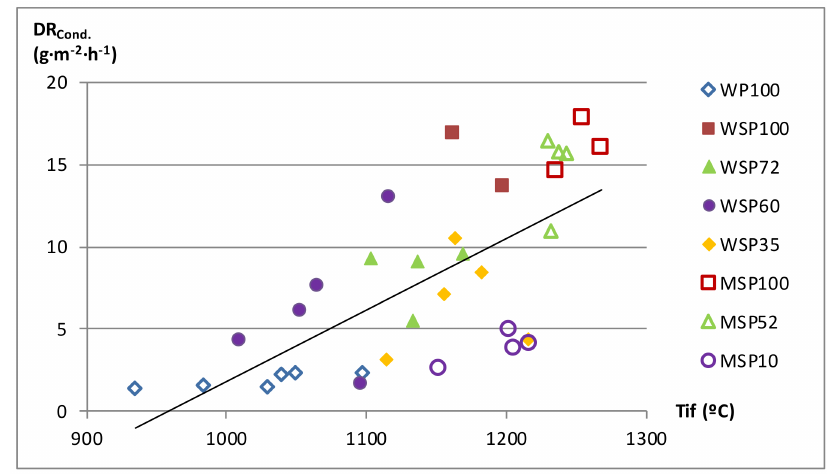
Figure 10. Deposition rates by condensation versus Tif.